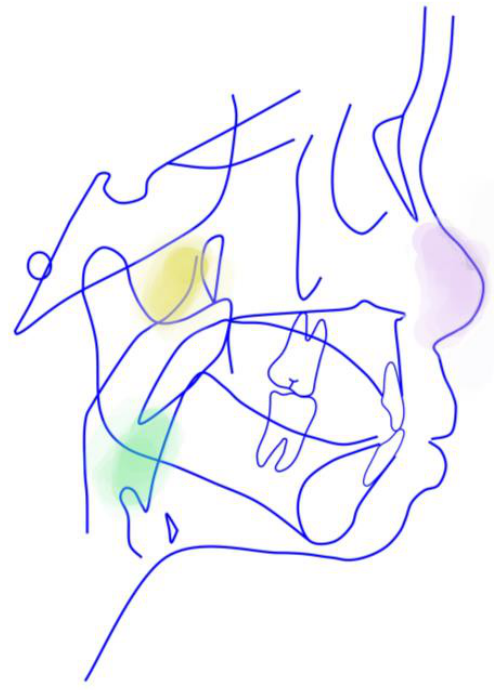
Figure 12. Schematic of upper airway multisite obstruction clinical manifestations.